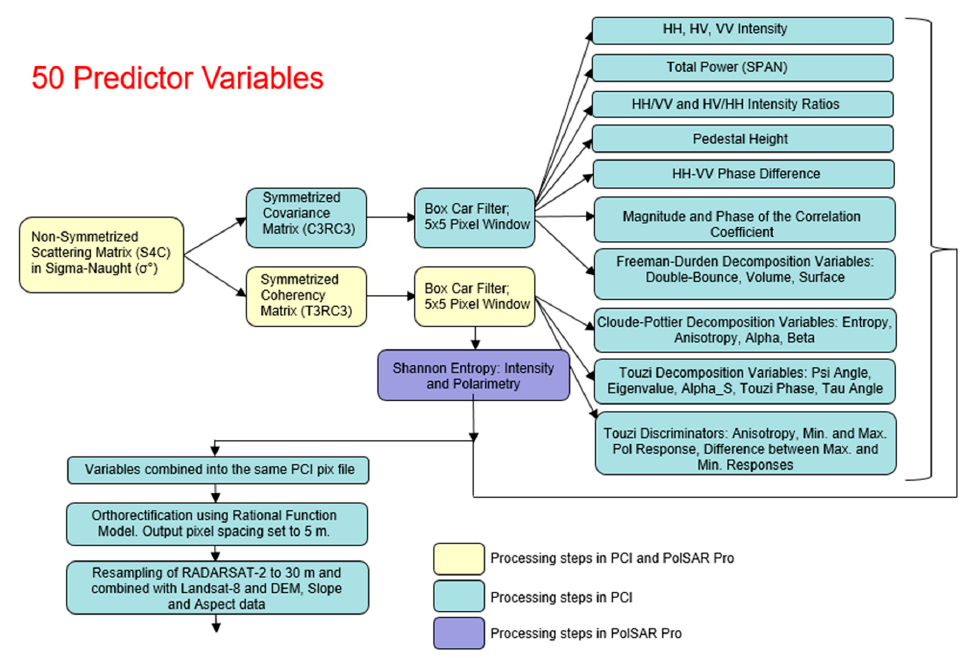
Figure 3. Processing steps used in PCI Geomatica 2015 and PolSAR Pro to generate the 50 predictor variables that were used in the RADARSAT-2 RF model (recreated after [50]). Remote Sens. 2017 , 9 , x FOR PEER REVIEW